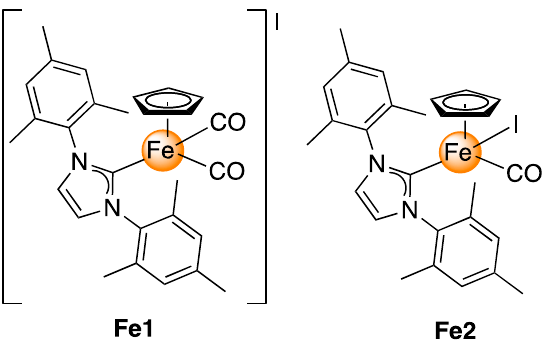
Figure 1. Molecular structure of the Fe–NHC complexes tested in this work.